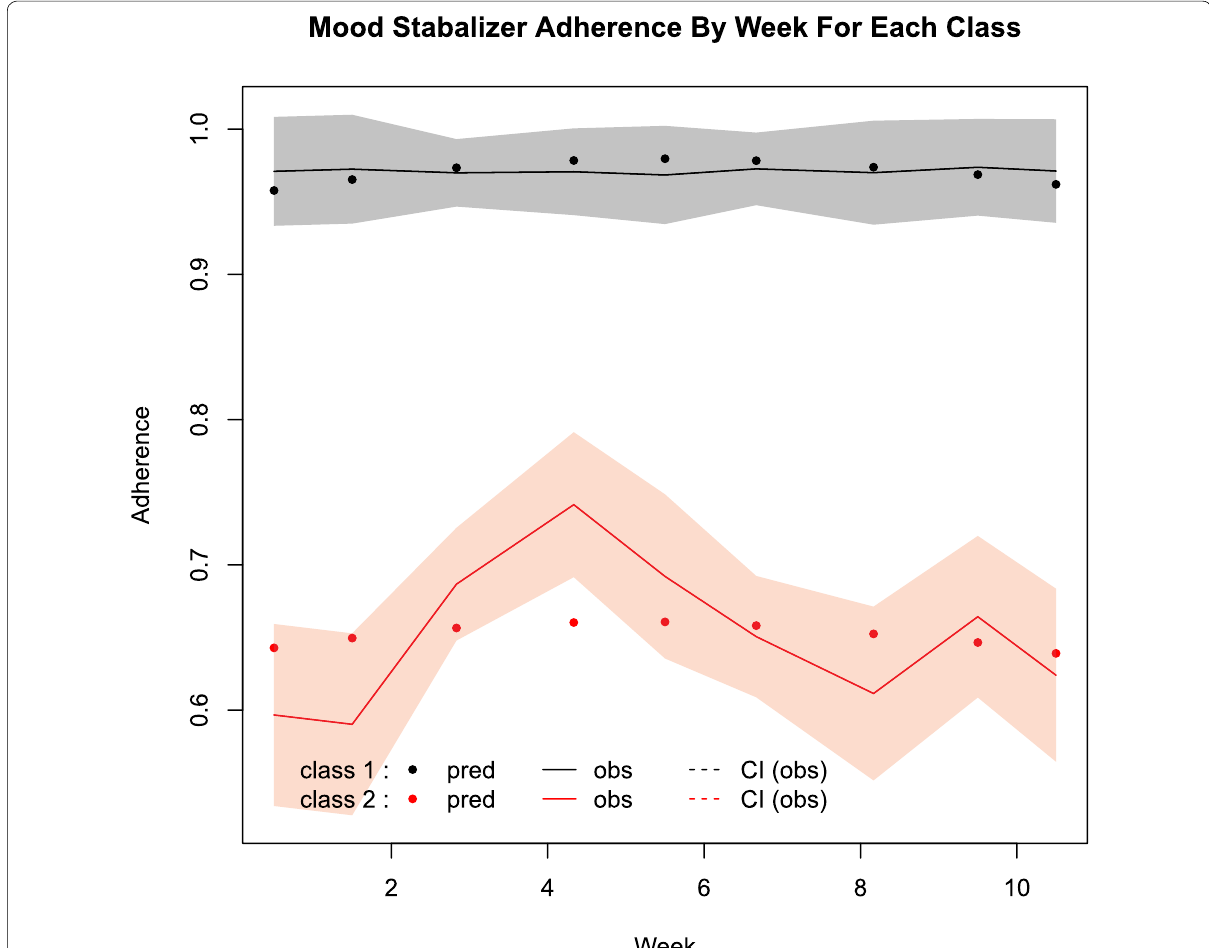
Fig. 1 Mood stabilizer adherence by week for each class. pred predicted adherence, obs observed adherence, CI 91% confidence